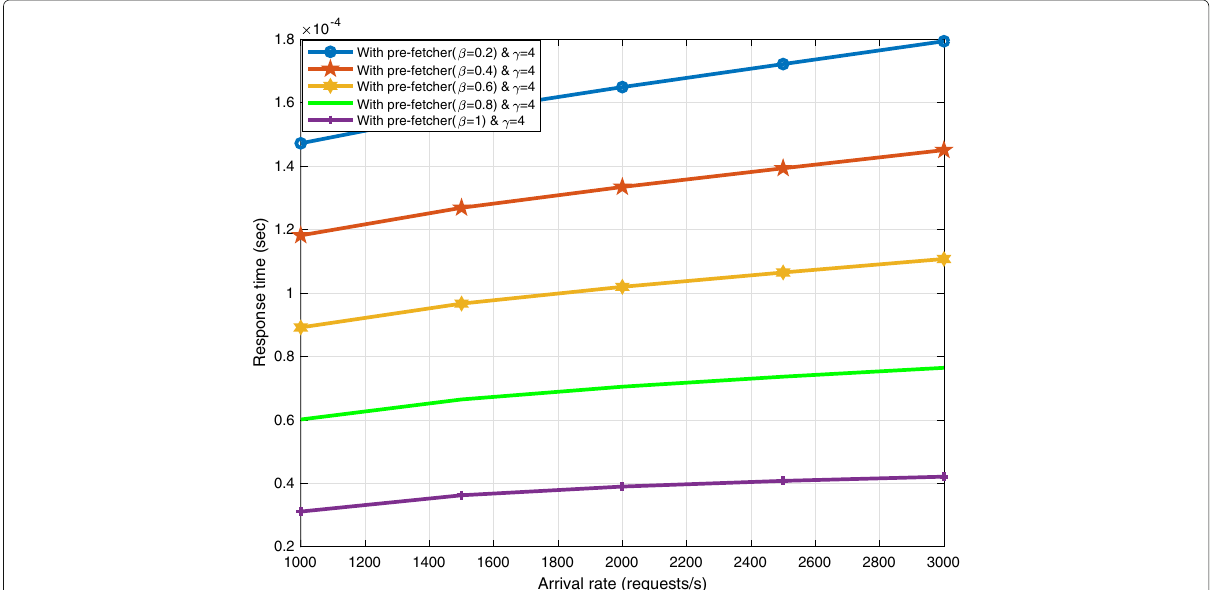
Fig. 4 Response time vs. arrival rate while the workload is shared between multimedia cloud and pre-fetcher at probability distribution of β . With pre-fetcher ( β = 0.2) and γ = 4, With pre-fetcher ( β = 0.4) and γ = 4, With pre-fetcher ( β = 0.6) and γ = 4, With pre-fetcher ( β = 0.8) and γ = 4, With pre-fetcher ( β = 1) and γ =